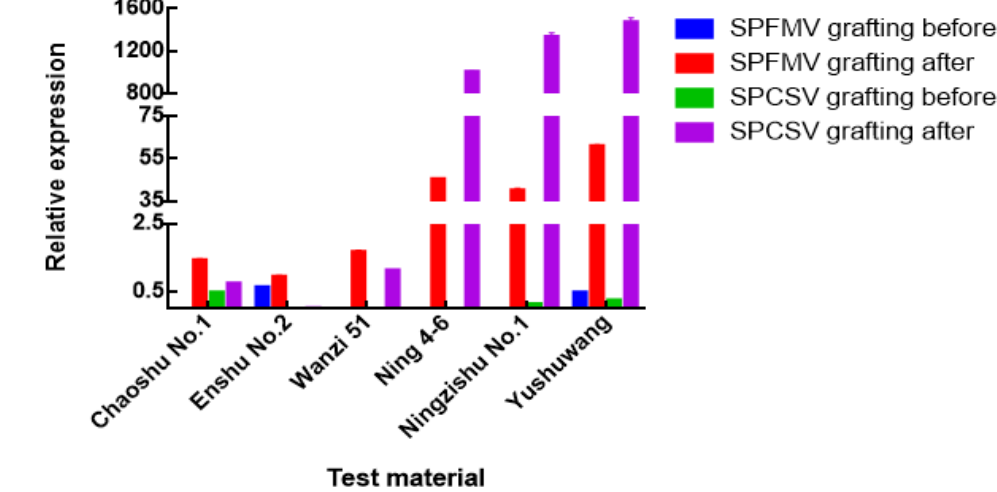
Figure 4. QRT-PCR was used to detect the relative expression levels of genes of SPCSV and SPFMV in 2017. Six varieties, Ningzishu No.1, Ning 4-6, Yushuwang, Wanzi 51, Chaoshu No.1 and Enshu No.2, were sampled before and after grafting with virus seedlings. Error bars indicate the standard deviation from three independent replicates.